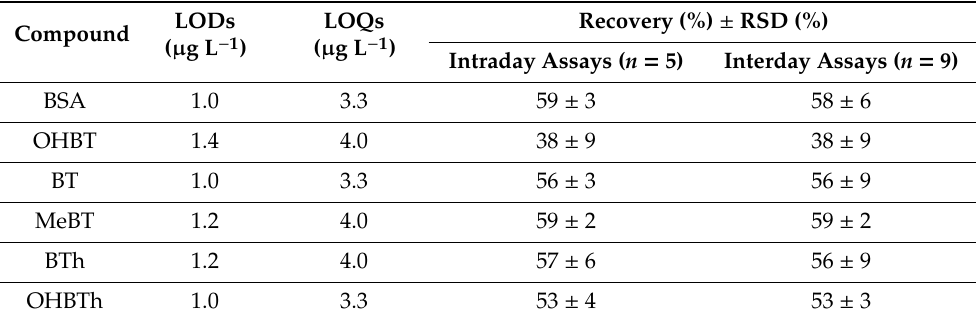
Table 1. Limits of detection (LODs) and limits of quantification (LOQs) as well as intraday and interday repeatability of recovery assays obtained for BSA, OHBT, BT, MeBT, BTh, and OHBTh chemicals